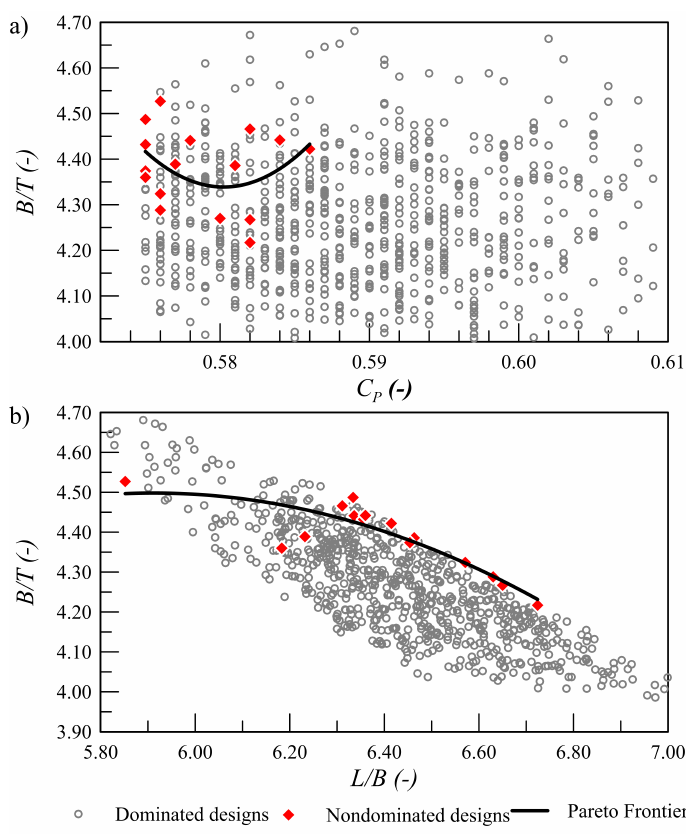
Figure 10. Distribution of breadth-draught ratio as a function of prismatic coefficient ( a ) and lenght- breadth ratio ( b